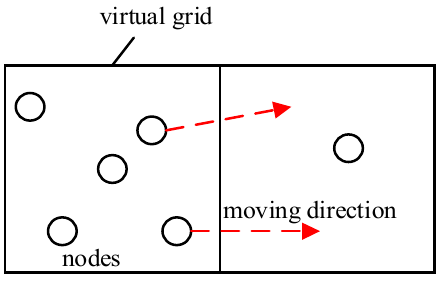
Figure 5. The diffusing phase of GEBRP [57].